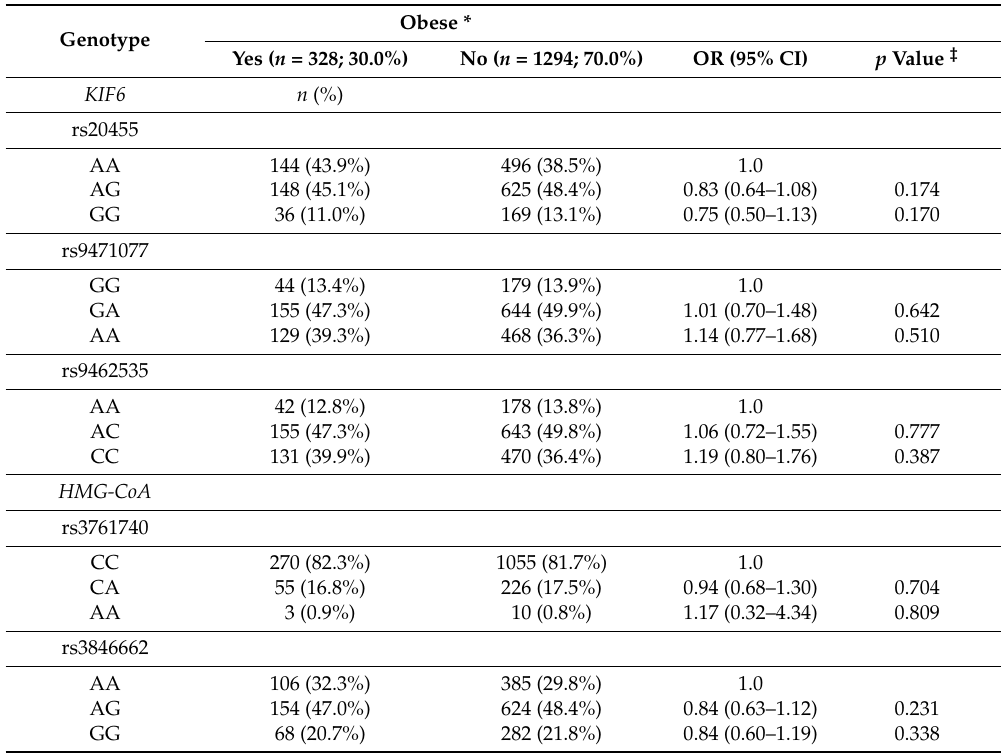
Table 4. Influence of KIF6 and HMG-CoA genotypes † on obesity, calculated according to BMI.